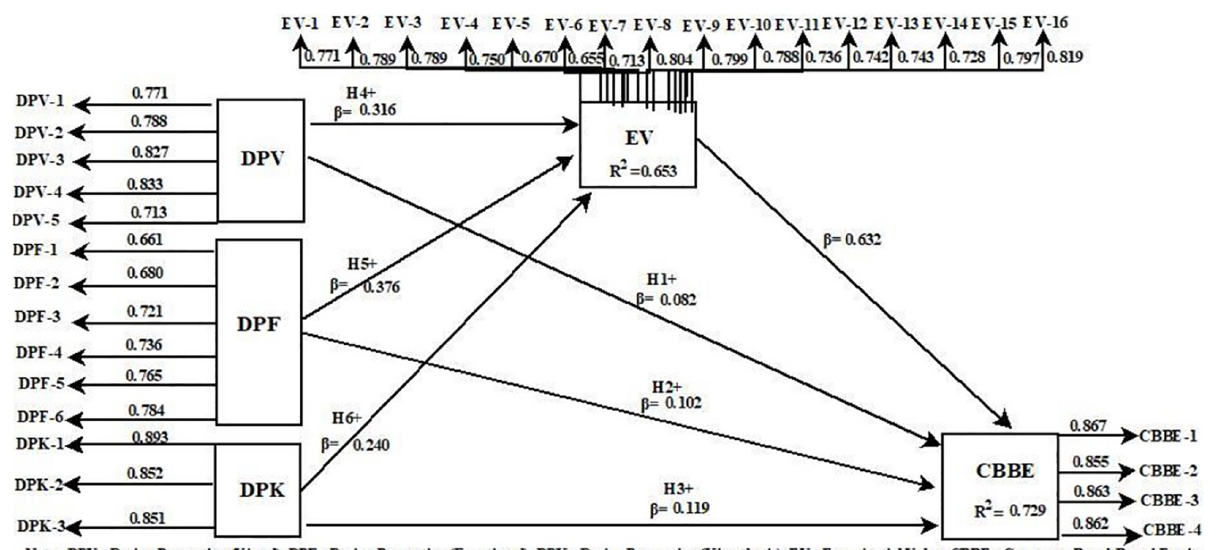
FIGURE 2 | Developed